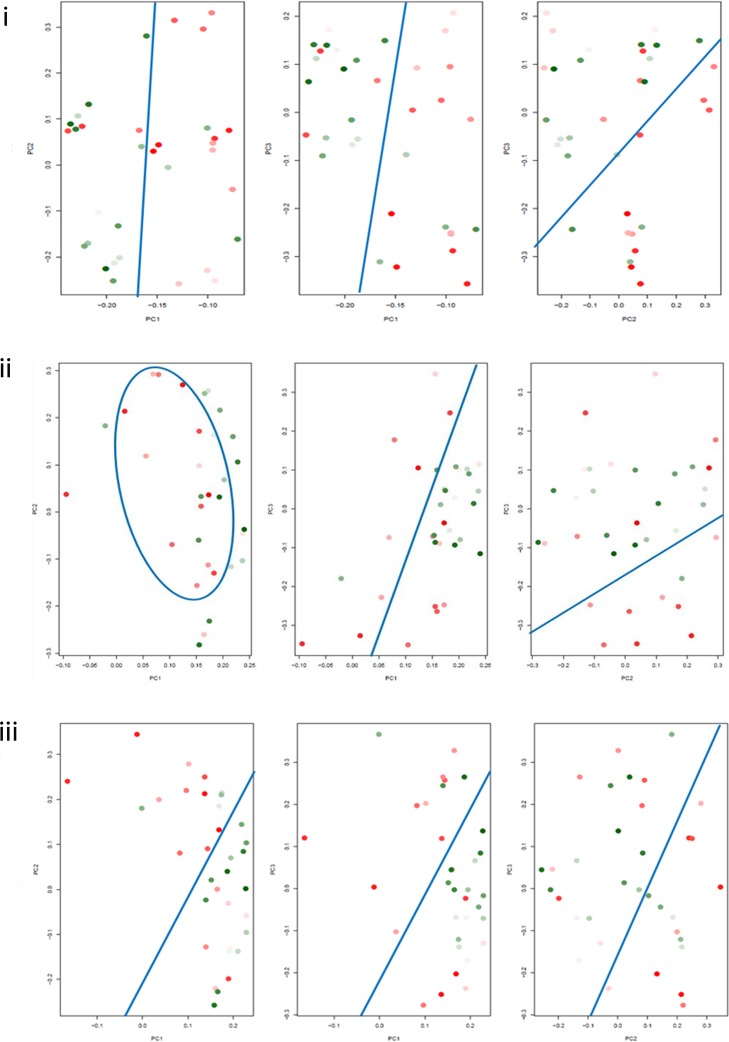
2D PCA plots showing clustering of high and low PGK1 expressing GBM tertiles on the basis of differential expression of Notch pathway genes.Each data point in a plot denotes a GBM and depicts the score created by weighted summation of Notch genes’ expression in that tumor. The colour gradient from darkest red to darkest green denotes the highest PGK1 expression to the lowest PGK1 expression in the data points representing tumors. The demarcation between high PGK1 GBM tertile and low PGK1 GBM tertile in each plot has been displayed by using either lines or curves (blue coloured) which have been drawn manually to reveal the closely spaced cluster. Cluster formation was assessed by counting the number of the darkest red and the darkest green data points on both sides of the line; or those enclosed within the curve. GBM scores were created by the combination of either (i) all 15 Notch genes or (ii) 7 Notch genes (Notch1, Dll1, Dll4, Hes1, Hes6, Hey1, Hey2) and (iii) 6 Notch genes (Notch1, Dll1, Hes1, Hes6, Hey1, Hey2) selected on the basis of PGK1 heat map. Similar to the case of HIF-1α, PGK1-ordering of the tumors also generated well-separated clusters of high and low tertiles based on 15 Notch genes’ expression.